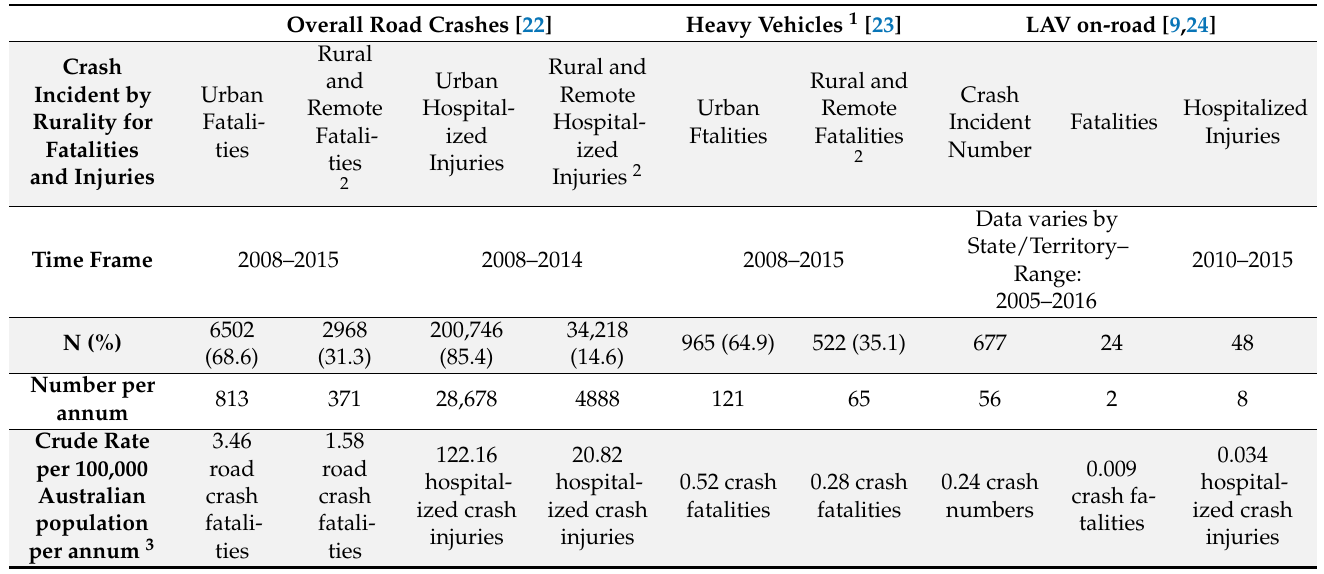
Table 1. Australian national data on road transport fatalities and injuries by vehicle type and rurality of